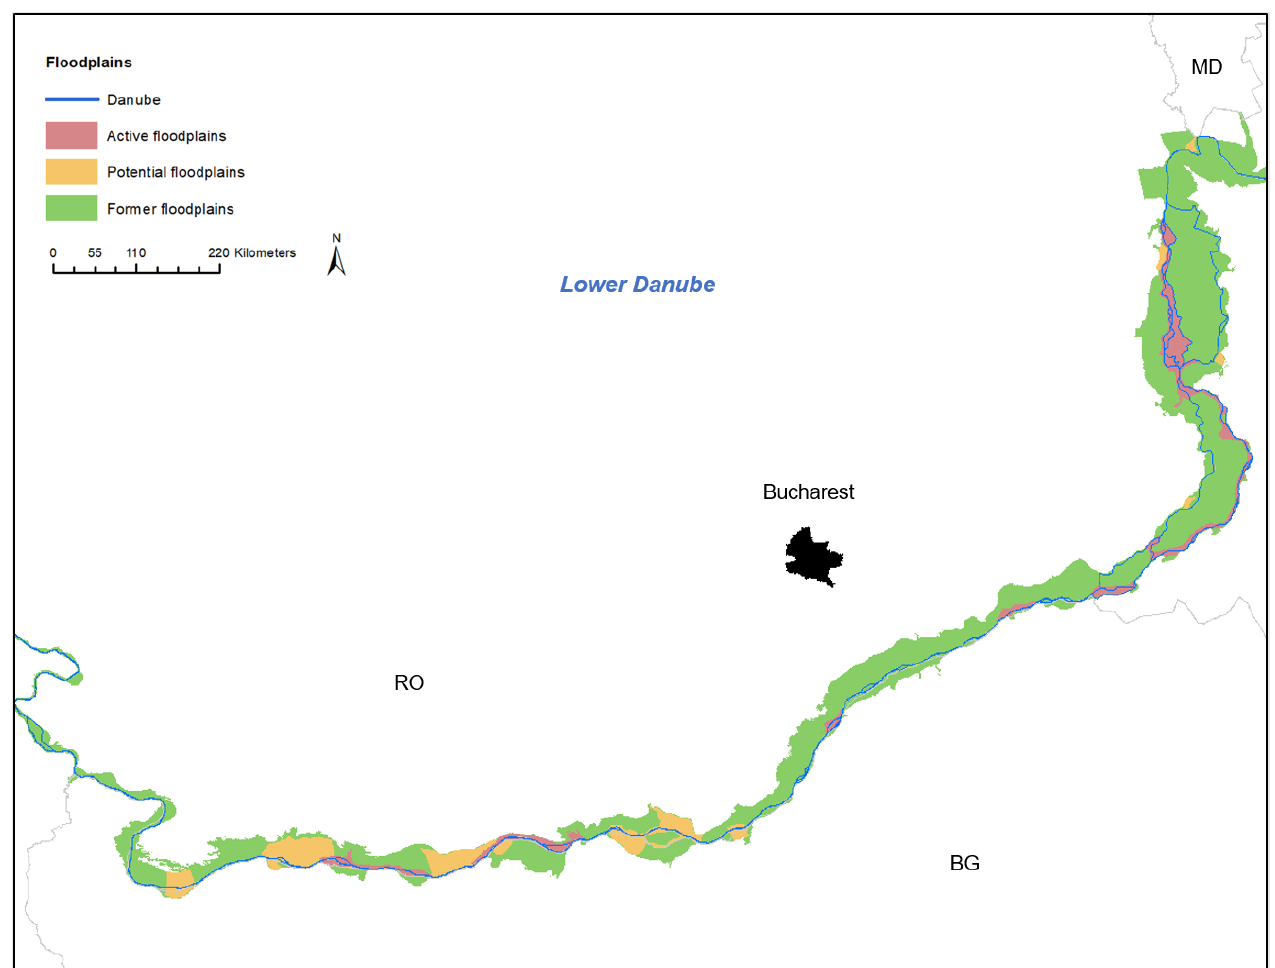
Figure 5. Overview of the active, former, and potential floodplains at the Lower Danube.